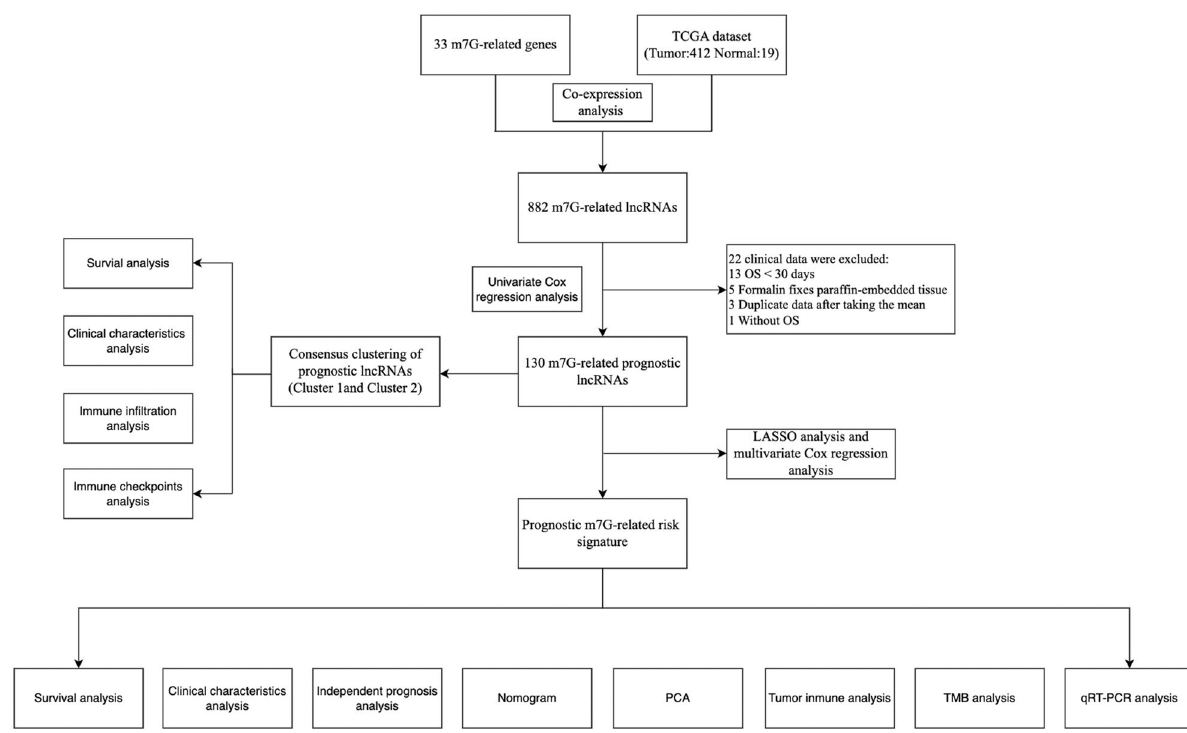
Figure 1. The flow